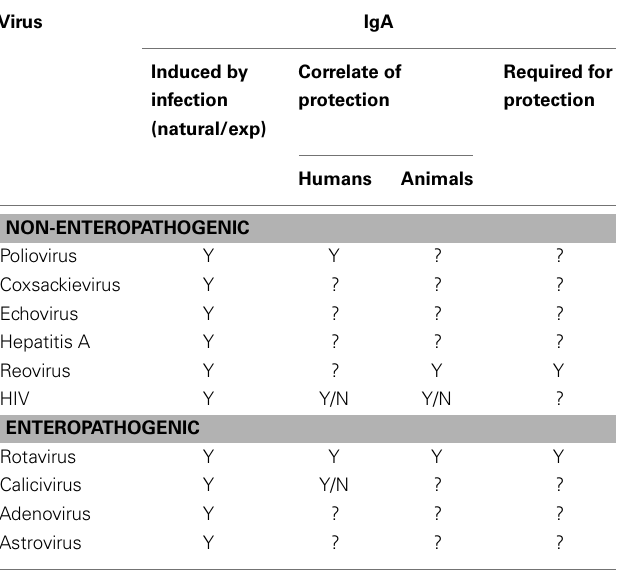
Table 1 | Role of IgA in protective from non-enteropathogenic and pathogenic intestinal viral infections